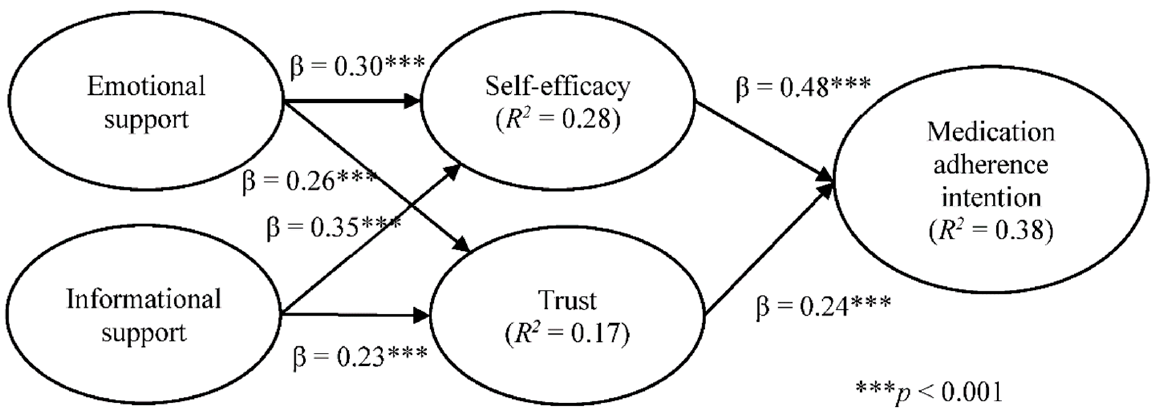
Figure 4. Structural model results for non-healthcare professional communities.